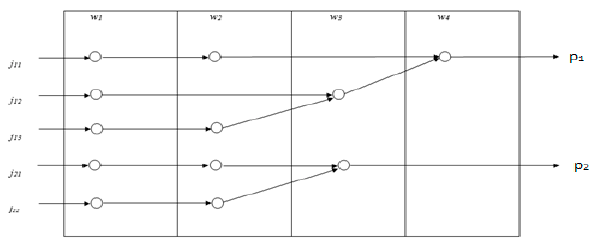
Figure 2. Processing of parts in the assembly flow-shop problem.